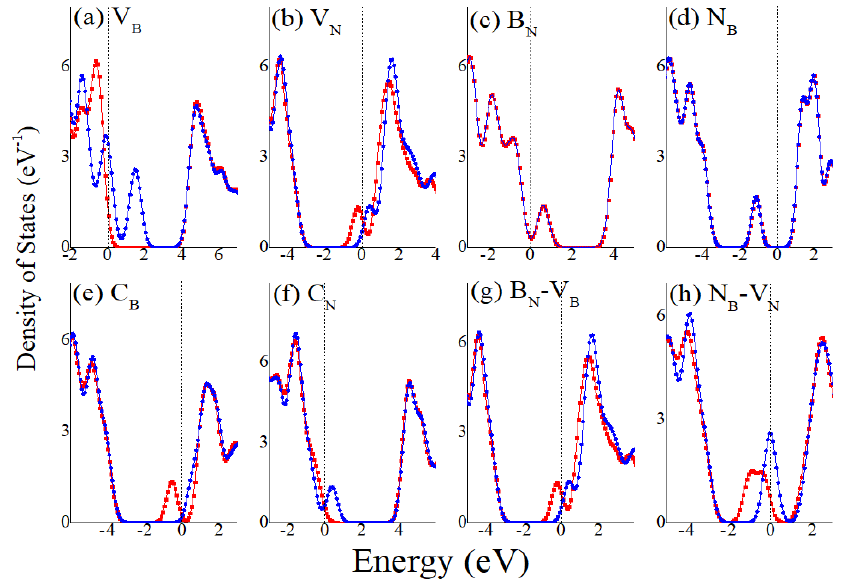
Figure 3. Spin-resolved electronic density of states (DOS) of hBN monolayer with various defects of ( a ) V B ; ( b ) V N ; ( c ) B N; ( d ) N B ; ( e ) C B ; ( f ) C N ; ( g ) B N -V B ; and ( h ) N B -V N . The vertical dotted lines indicate the Fermi energy level, which is pinned to 0 eV. The red and blue lines indicate the spin-up and -down DOS.